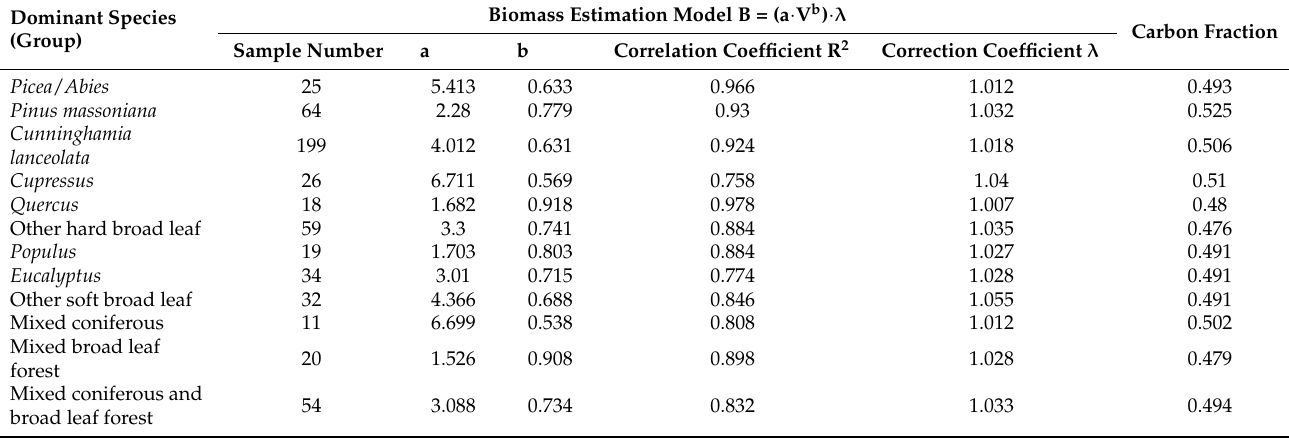
Table A7. Biomass estimation model and carbon accounting factors for main arbor forests in